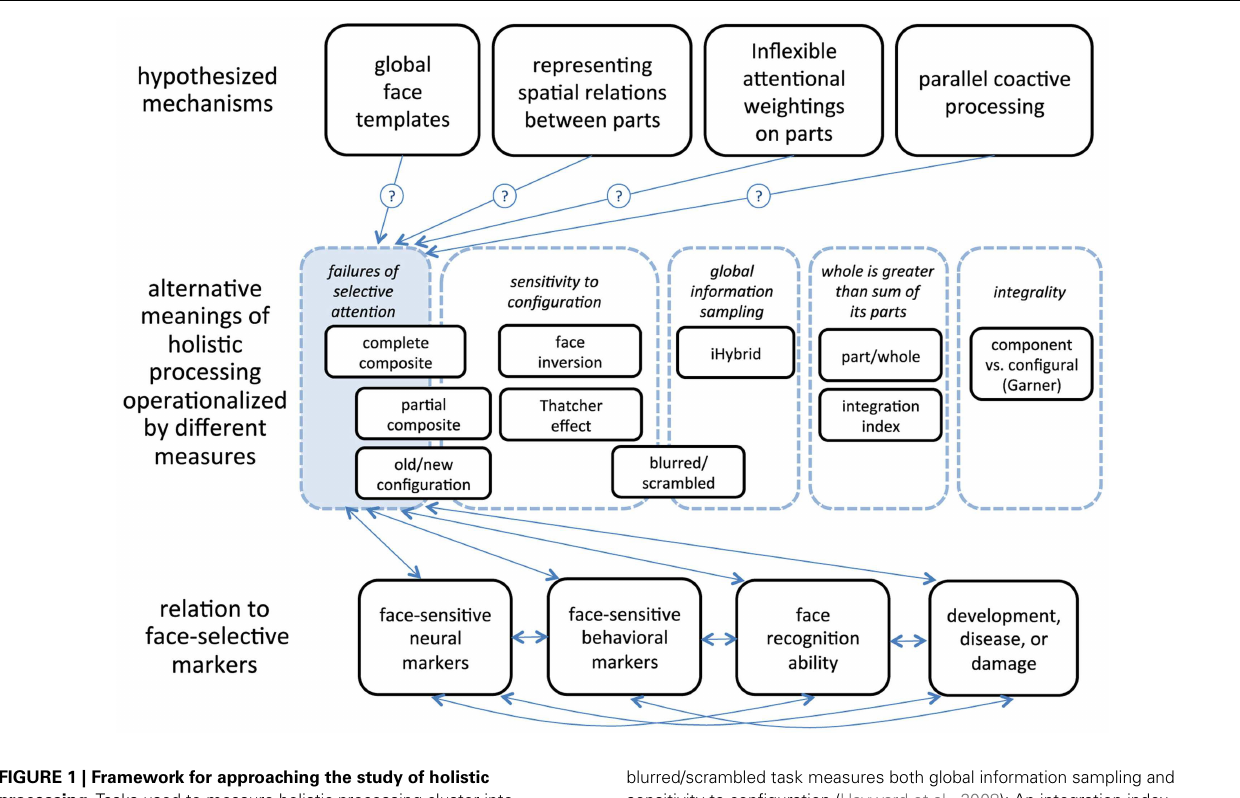
FIGURE 1 | Framework for approaching the study of holistic processing. Tasks used to measure holistic processing cluster into different possible meanings.The partial design (Robbins and McKone, 2007) and complete design (Richler et al., 2008b) of the composite task and the old/new configuration task (Tanaka and Sengco, 1997) measure failures of selective attention and to some extent sensitivity to configuration; theThatcher illusion (Thompson, 1980) and the face inversion effect (Yin, 1969) measure sensitivity to configuration; iHybrid (Miellet et al., 2011) measures the use of global information sampling;The